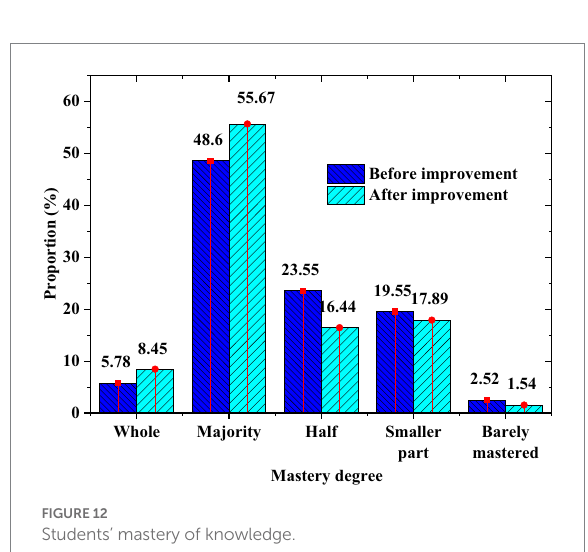
FIGURE 13 Students’ attention to Olympic